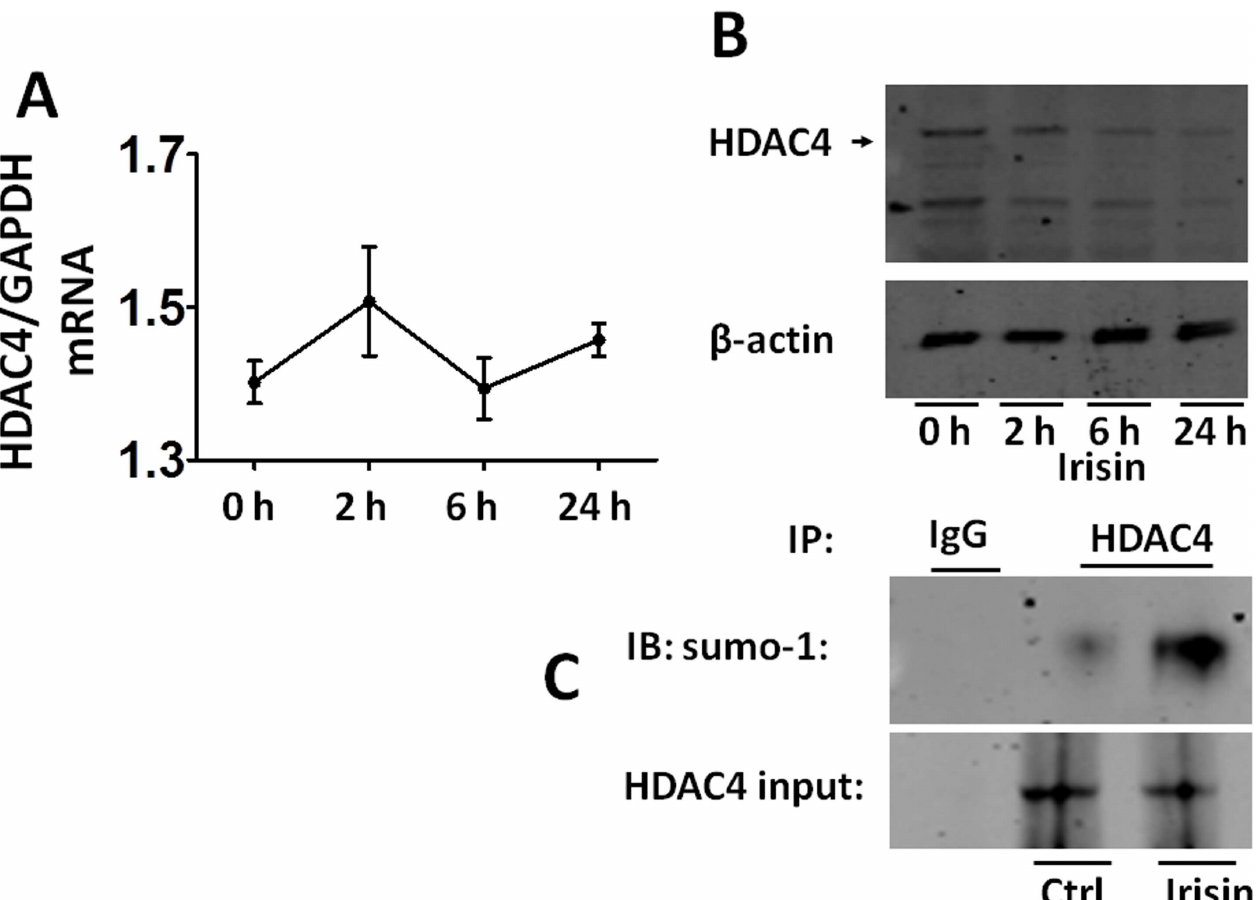
Fig 7. Effect of irisin on HDAC4 expression in transcriptional and protein levels. (A) Quantitative PCR results of HDAC4. It showedthat irisin did not influenceHDAC4 mRNA. (B) Western blot analysisof HDAC4. Irisin treatment resulted in a time-dependent decreasein HDAC4 level. The results represent 3–4 independentexperiments. (C) Immunoprecipitationshowingthat irisin inducedHDAC4 sumoylationin H9c2 cardiomyoblasts exposedto H/R. These results represent 3–4 independent experiments. IgG: ImmunoglobulinG. IP: immunoprecipitation.